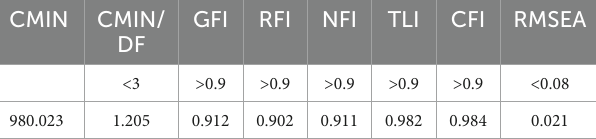
TABLE 7 The structural model goodness-of-fit indices.